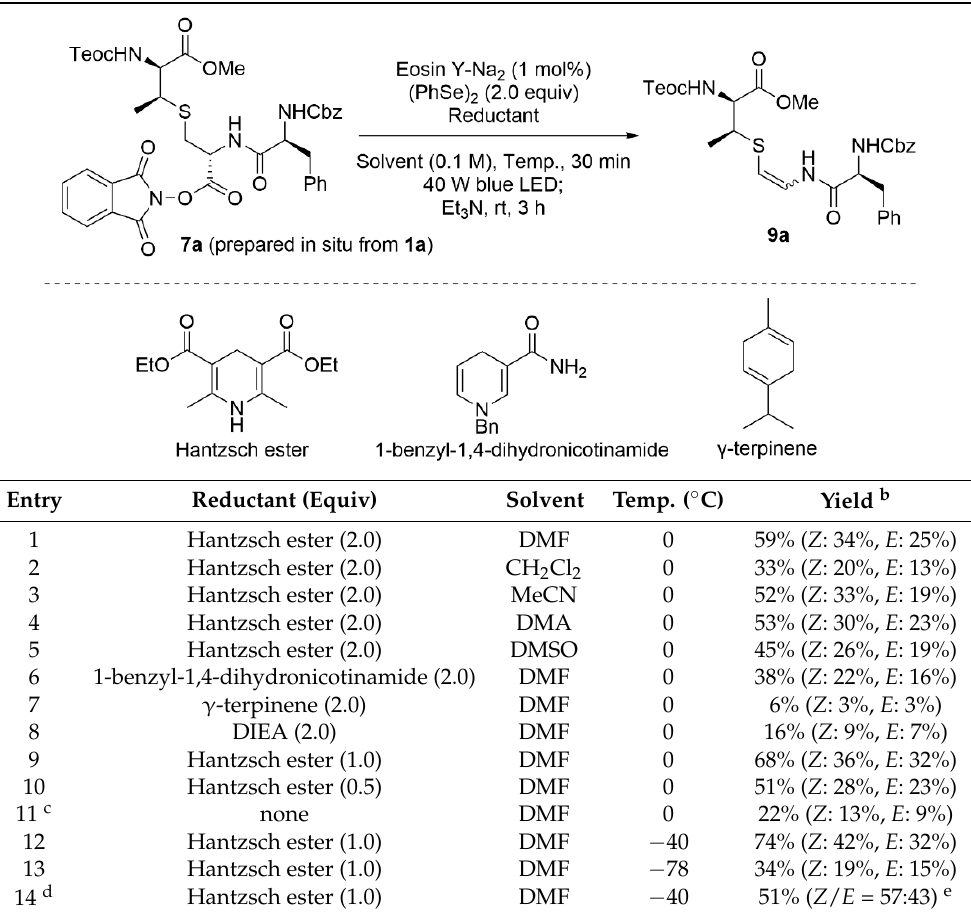
Table 2. Optimization of reaction conditions a .